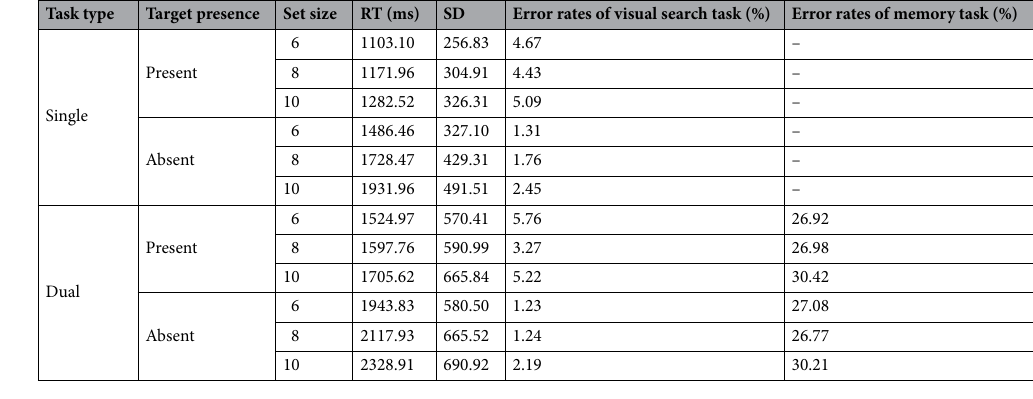
Table 3. Response time and error rates in Experiment